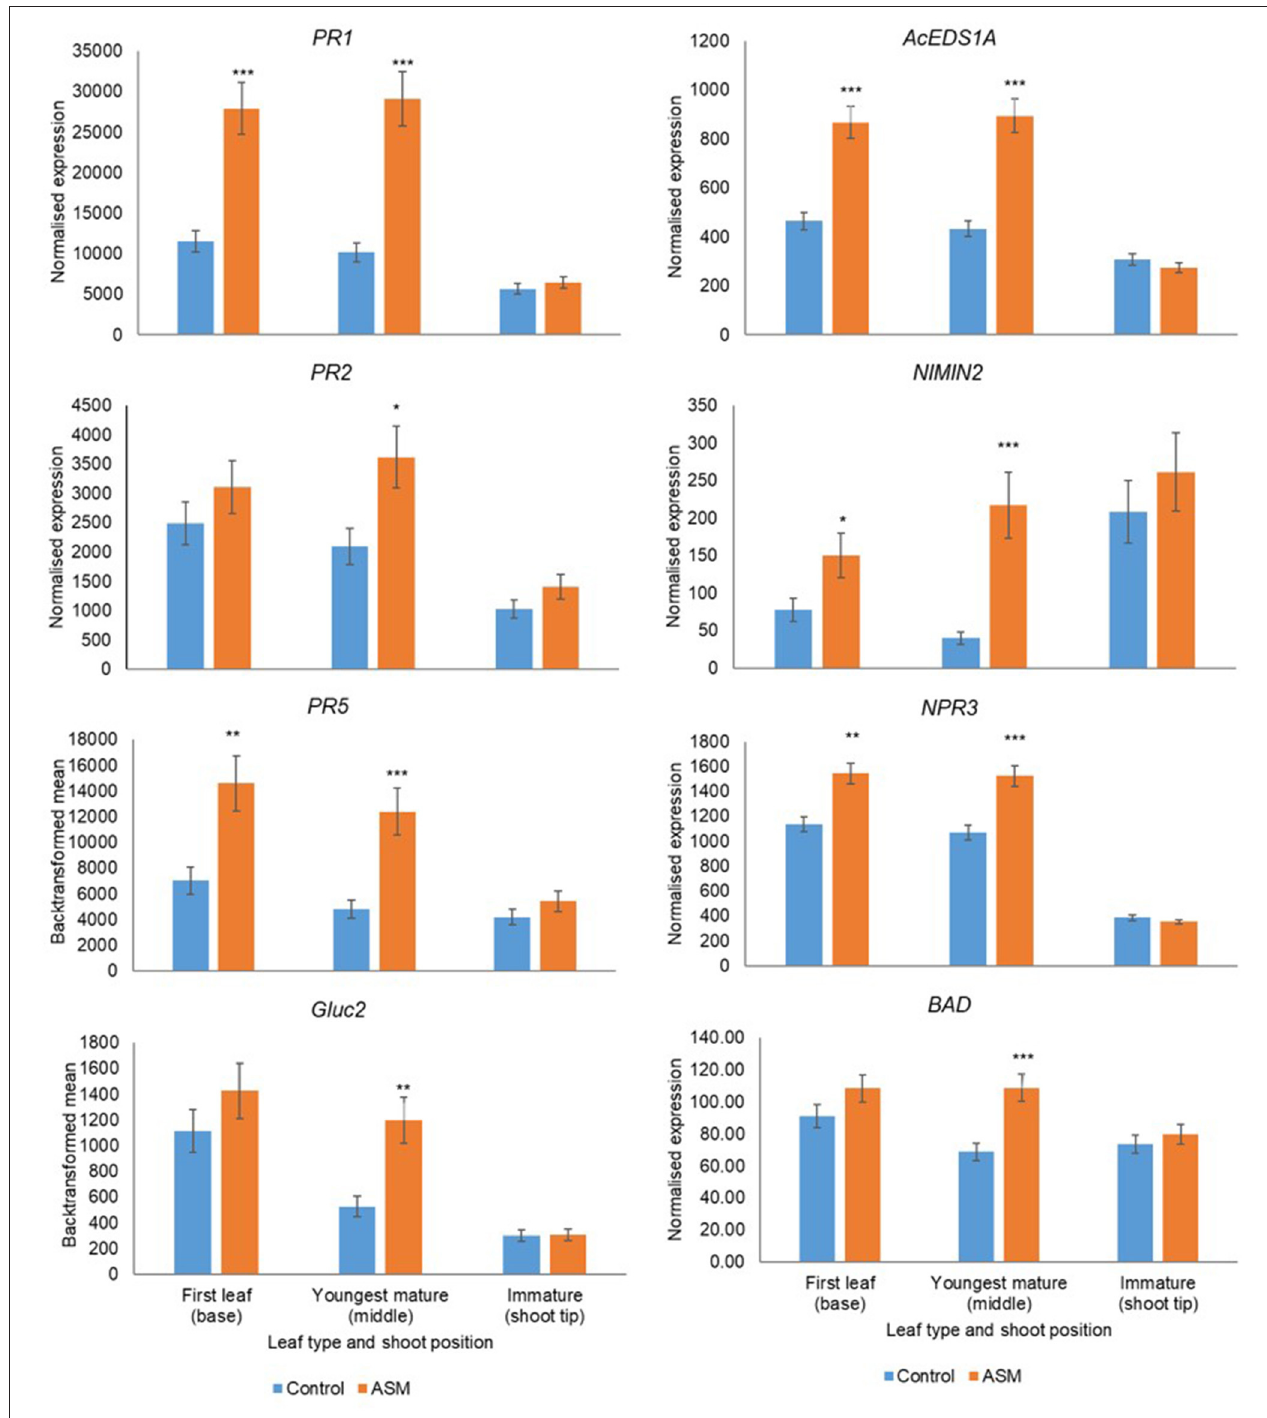
FIGURE 6 | Expression of PR1, PR2, PR5, AcEDS1A, NIMIN2 , NPR3, and BAD in Actinidia chinensis var deliciosa ’Hayward’ leaves of differing maturity in spring 2018, as measured by PlexSet® NanoString, and the Y-axis represents physical counts of the number of molecules expressed. Actigard (ASM) was sprayed on 16 October, 31 October, and 13 November and leaves were sampled on 14 November. Data were normalised against six reference genes— 40s rRNA , actin , elongation factor , glyceraldehyde 3-phosphate dehydrogenase , protein phosphatase 2A , and ubiquitin-conjugating enzyme . Data were log 2 transformed for analysis, but are presented as back-transformed means. Asterisks above bars indicate significant treatment differences, where * < 0.05, ** < 0.01, and *** < 0.001.